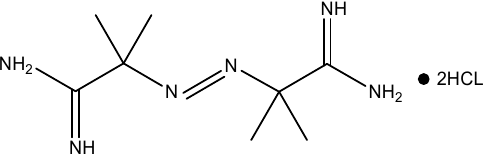
Figure 1. The chemical structure of AIBA.